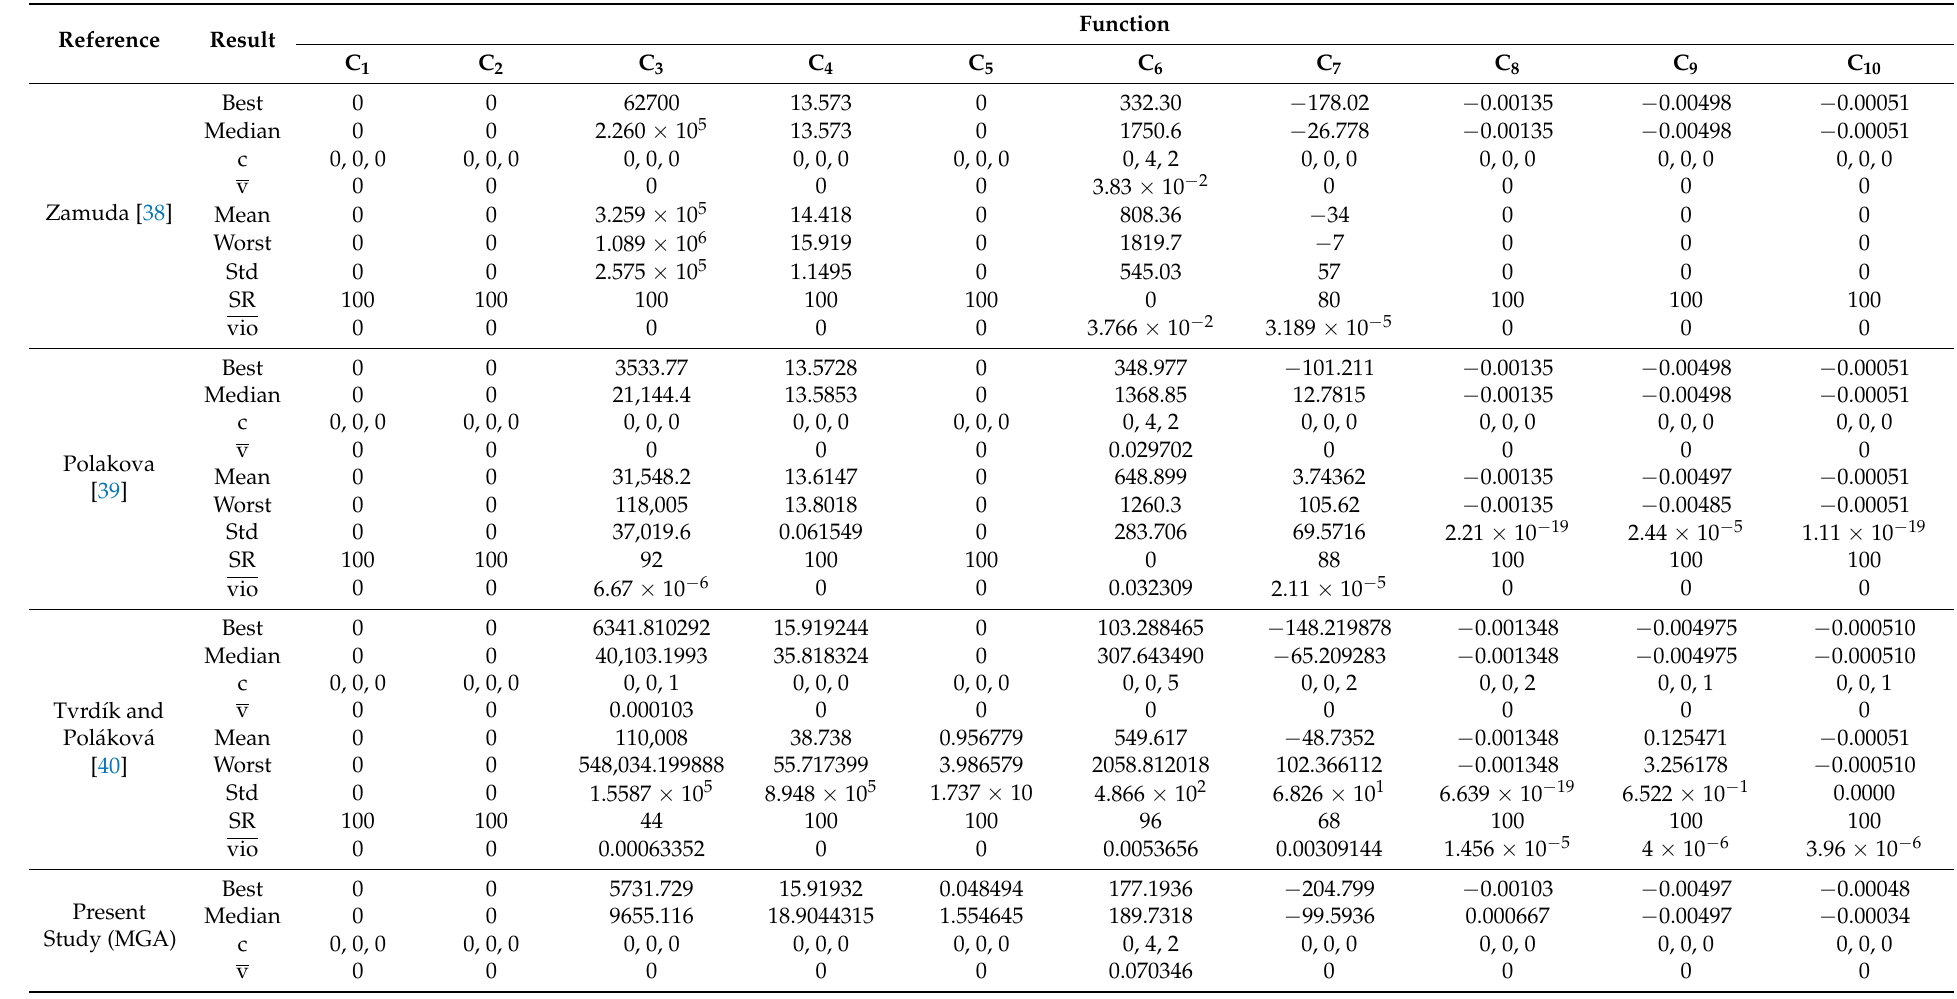
Table 4. Statistical results of different approaches for mathematical problems of CEC 2017 with 10